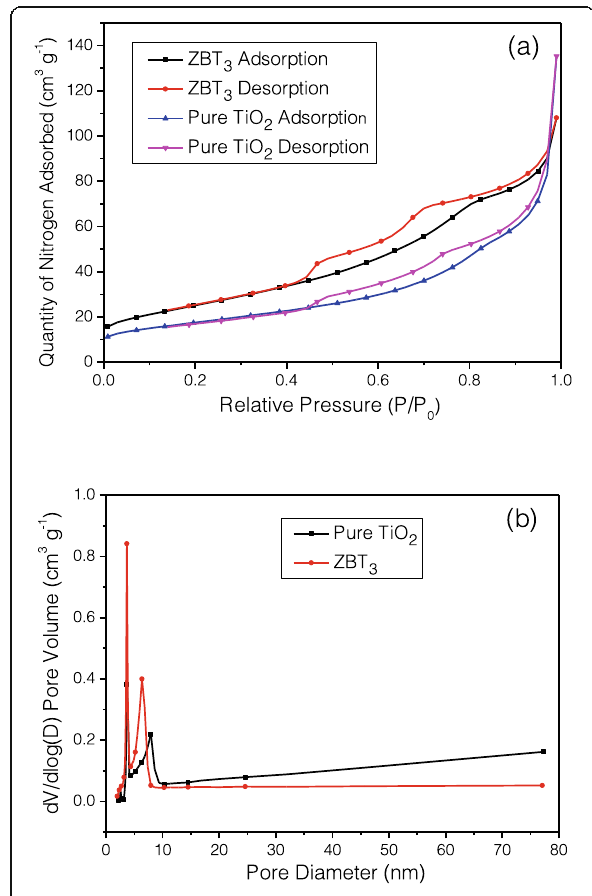
Fig. 7 ( a ) Nitrogen adsorption-desorption isotherms of ZBT 3 and ( b ) corresponding pore size distribution plot and undoped TiO 2